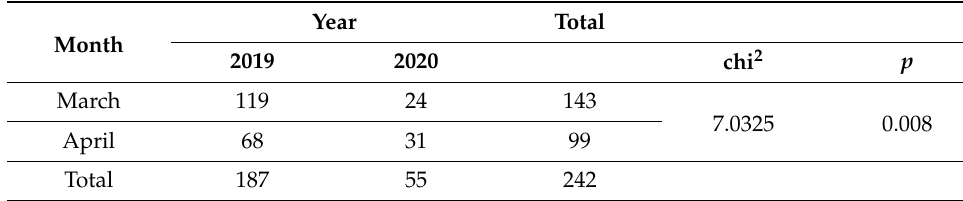
Table 5. The comparison of the number of intoxications at the beginning of the lockdown in 2020 connected with the COVID-19 pandemic, respectively, over the same months.